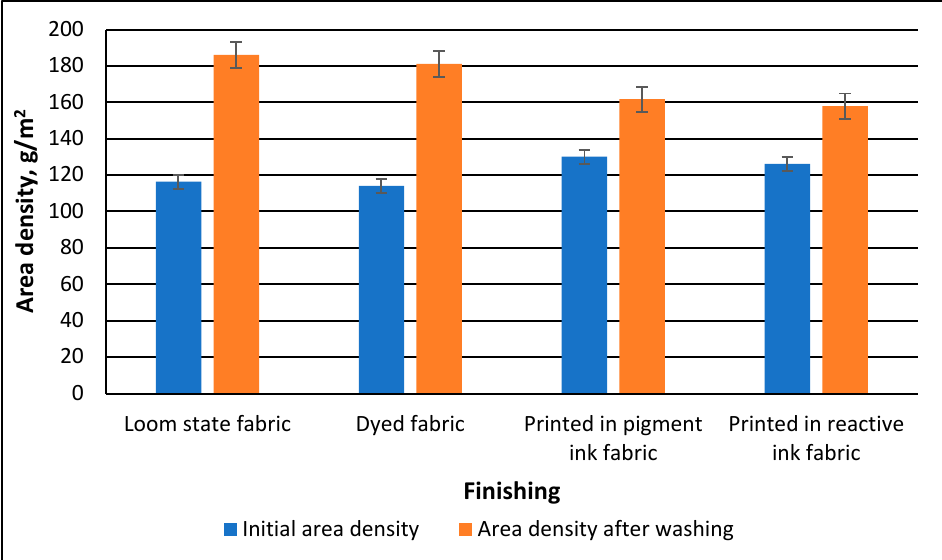
Figure 7. Alteration of fabric area density after washing.